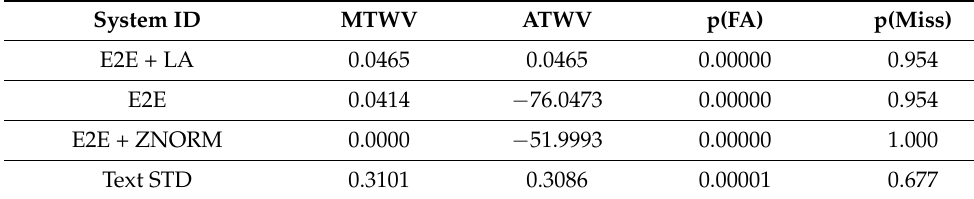
Table 14. System results of the QbE STD task for RTVE development